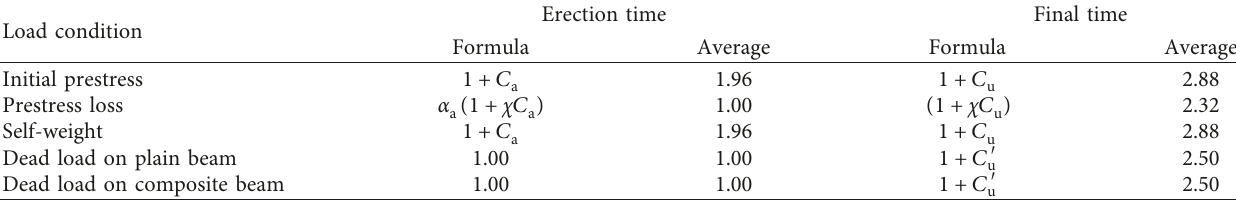
Table 2: PCI Bridge Design Manual improved multipliers